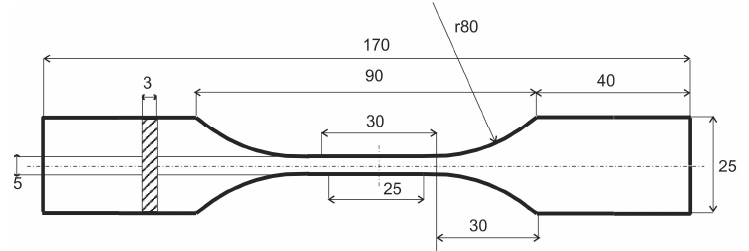
Figure 3. Nominal dimensions of the test specimen in mm.